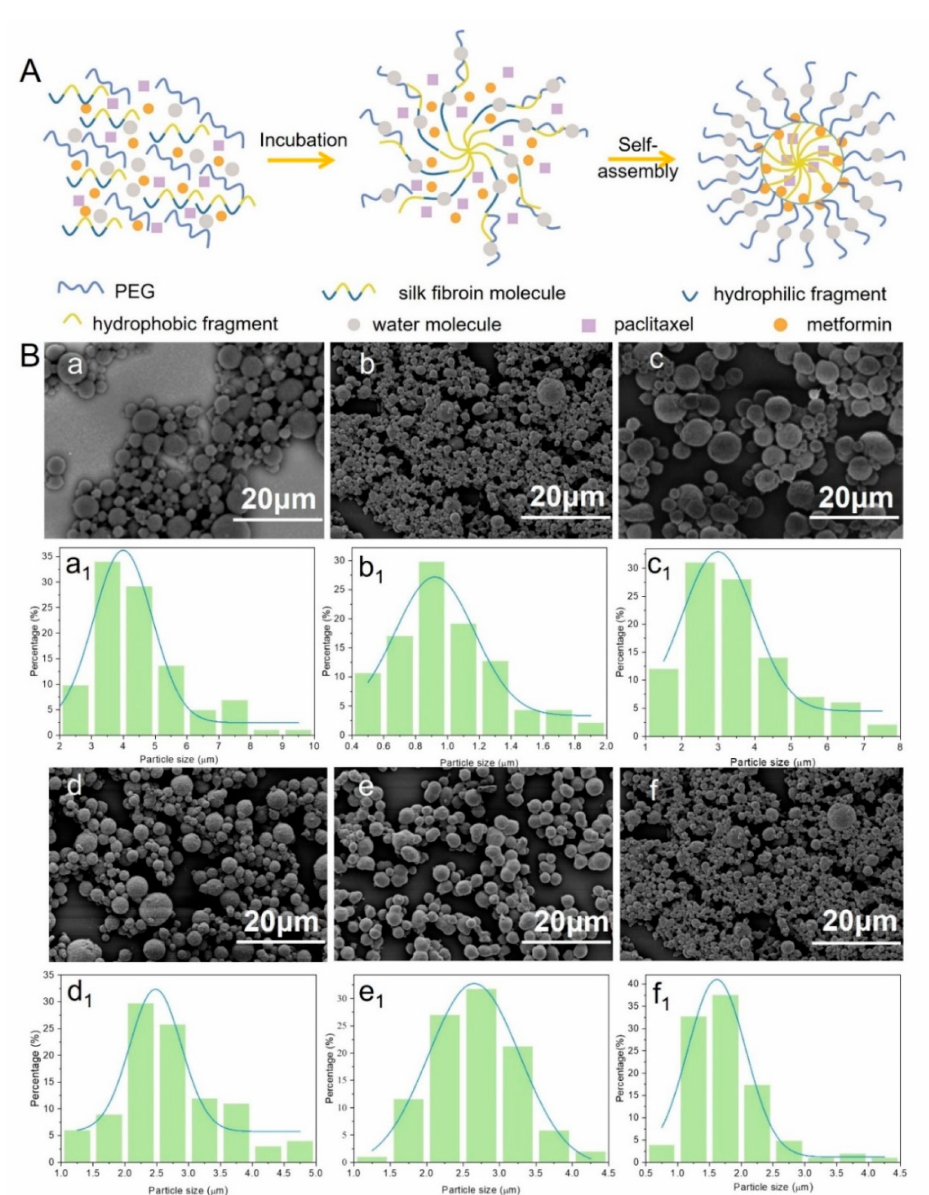
Figure 2. ( A ) Pellet-forming mechanism of drug-loaded silk fibroin microspheres; ( B ) Electron microscopy ( a – f ) and particle size distribution ( a 1 – f 1 ) of drug-loaded microspheres prepared with different parameters: ( a , a 1 ) SF, ( b , b 1 ) SF-PTX, ( c , c 1 ) SF-MT, ( d , d 1 ) SF-PTX-MT, ( e , e 1 ) SF-MET-MT, ( f , f 1 )